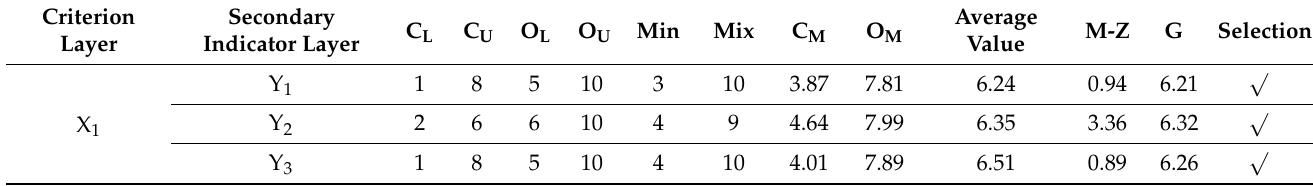
Table 1. Factor selection